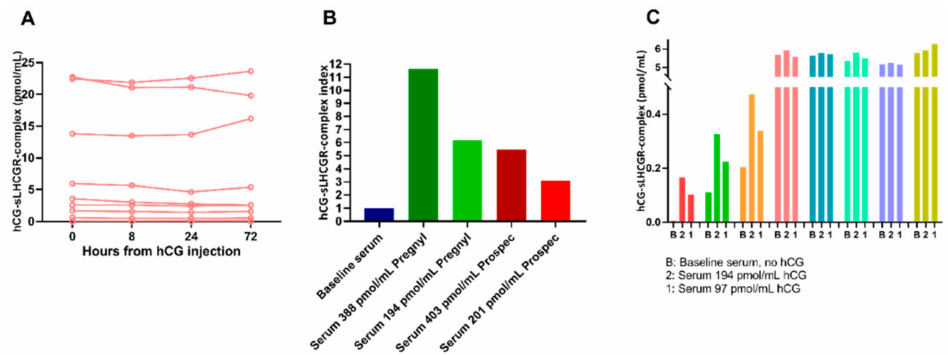
Figure 6. Sandwich-ELISA measuring hCG bound to sLHCGR in serum with and without inter- vention and proteins detectable in serum at the correct size. ( A ): The bound fraction hCG-sLHCGR before and after injection with 5000 IU hCG in 8 healthy men. ( B ): Measurement of the hCG-sLHCGR complex in a serum sample (blue: baseline), after spiking with 2 commercially available hCG prod- ucts in different concentrations (green and red, respectively) ( C ): Level of the hCG-sLHCGR complex in serum from 8 infertile men after spiking with hCG (Pregnyl) in 2